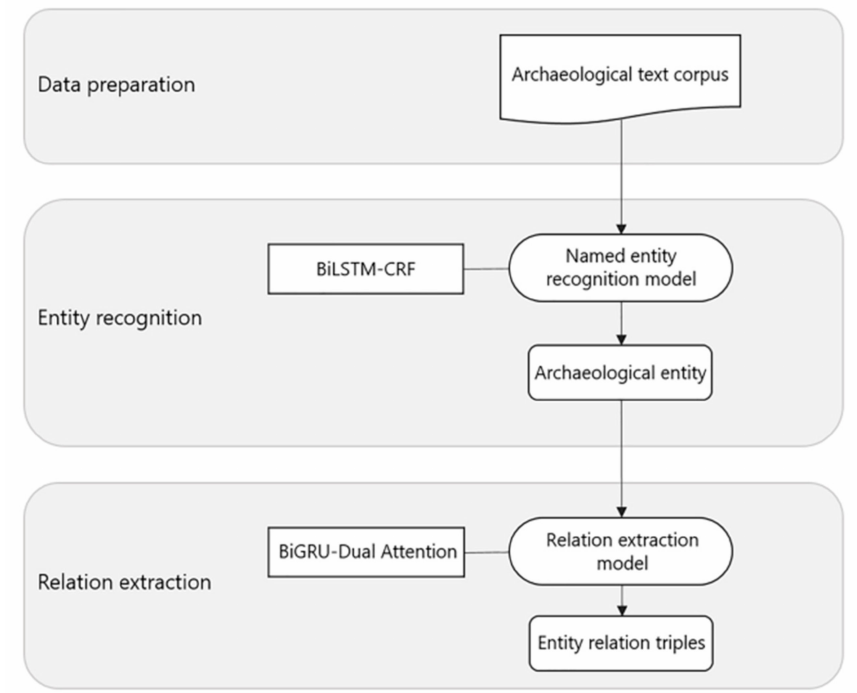
Figure 2. Flow chart of information extraction.